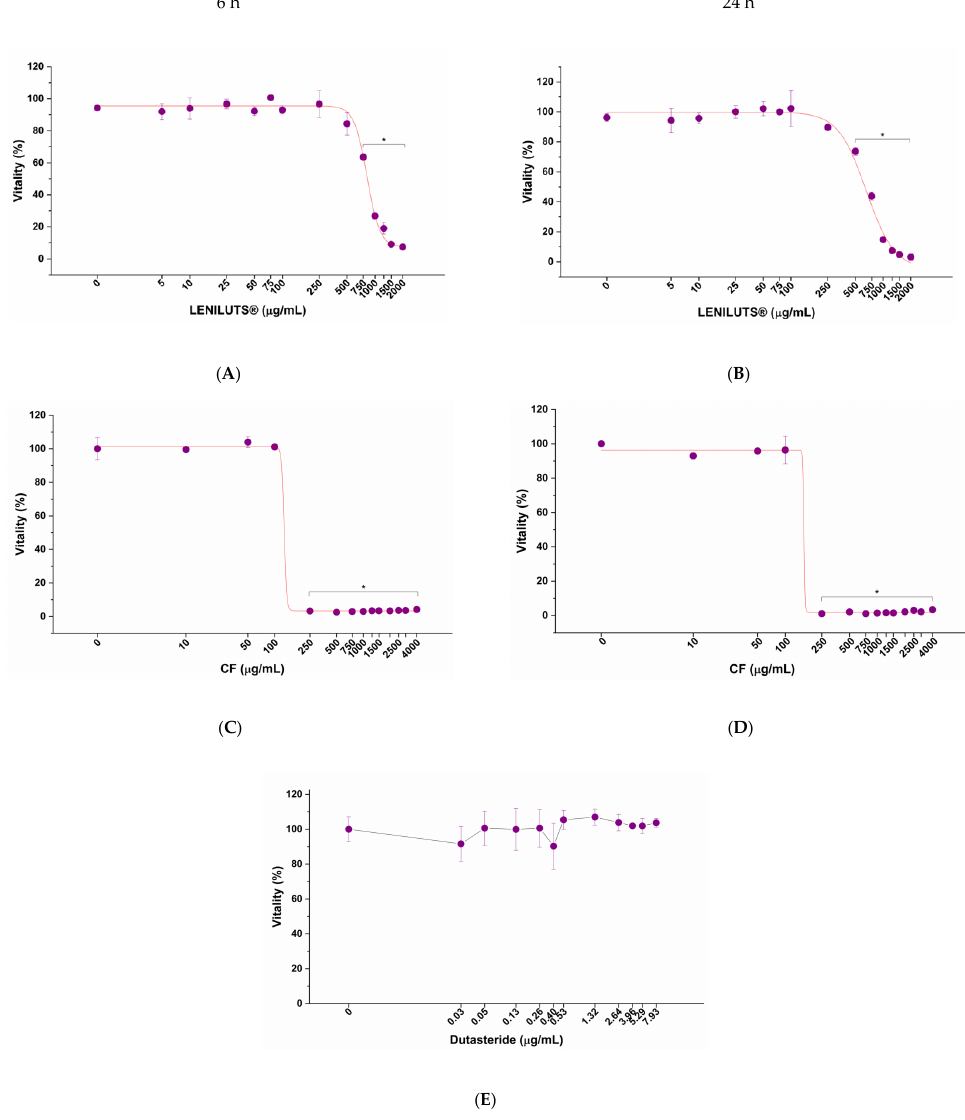
Figure 1. Impact of LENILUTS ® ( A , B ), CF ( C , D ) and Dutasteride ( E ) on in vitro prostate model vitality, following 6 and 24 h exposure. * p < 0.05.